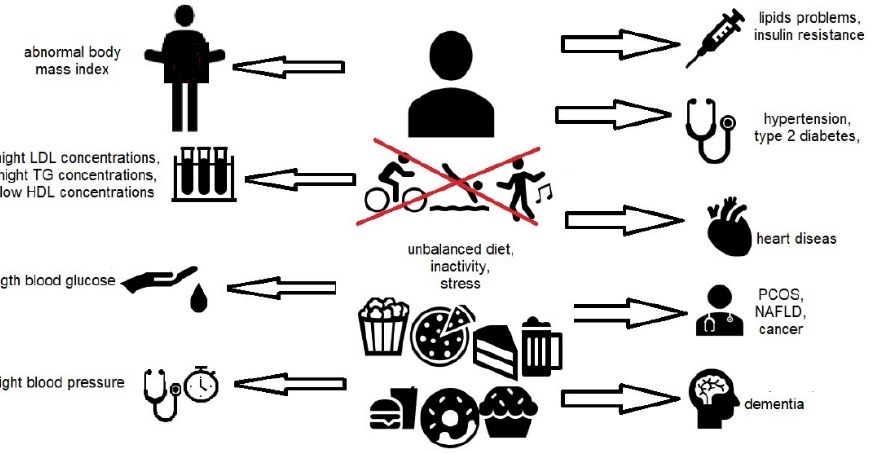
Figure 1. Metabolic syndrome factors /PCOS—polycystic ovary syndrome; NAFLD—non-alcoholic fatty liver disease/.